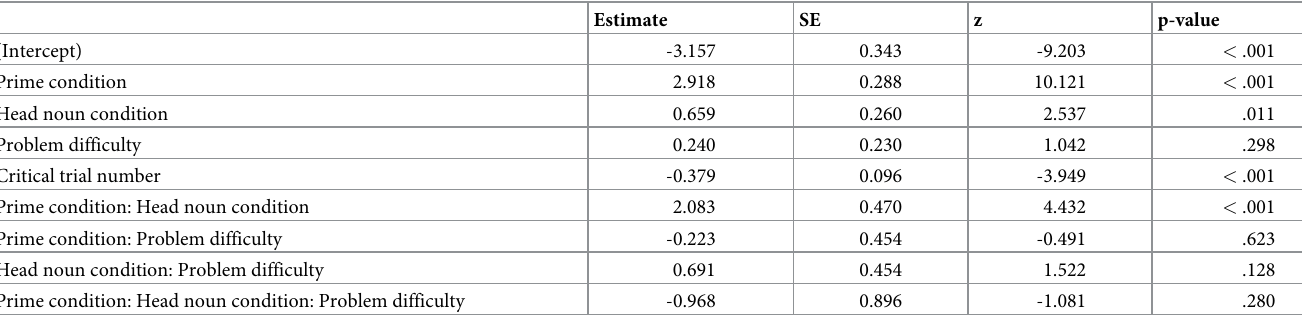
Table 2. Fixed effect estimates (in log odds units), Experiment